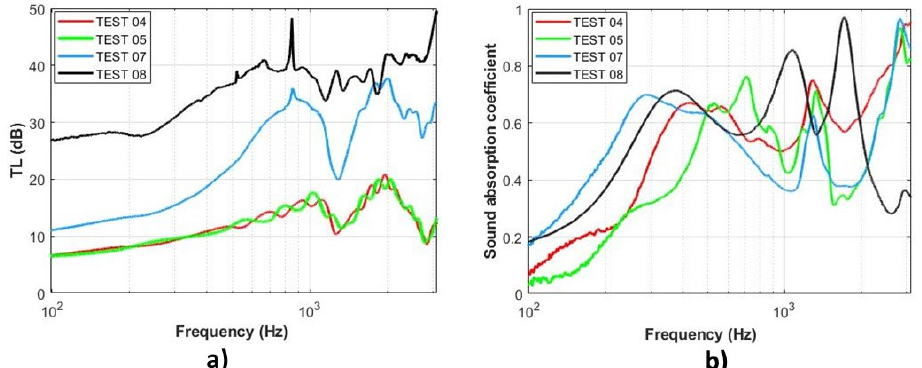
Figure 10. Transmission loss ( a ) and absorption coefficient ( b ) of samples made of egg-box, cardboard, polyester and a metallic